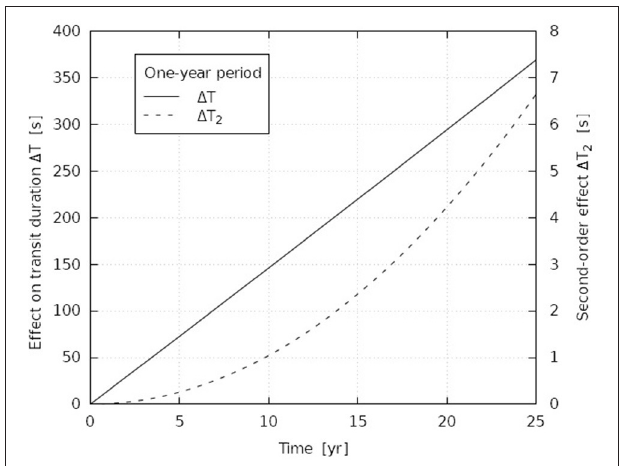
FIGURE 3 | As Figure 2 , but for a system with µ = 71masyr − 1 , cos i = 89. ◦ 74 and P =